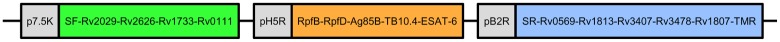
Schematic representation of the antigen fusions of MVATG18377.Three antigen fusions were inserted in the deletion III of MVA vector. The first fusion is constituted by the fusion of Rv2029, Rv2626, Rv1733 and Rv0111 proteins and is placed under the control of p7.5K promoter. The second fusion contains a fusion of RpfB-RpfD, Ag85B, TB10.4 and ESAT-6 proteins and its expression is driven by the pH5R promoter. The third fusion is constituted by the fusion of Rv0569, Rv1813, Rv3407, Rv3478 and Rv1807 proteins and is placed under the control of pB2R promoter. SF, signal peptide of the F protein of measles virus. SR, signal peptide of the glycoprotein precursor of rabies virus ERA strain. TMR, membrane-anchoring peptide derived from the rabies glycoprotein of PG strain.